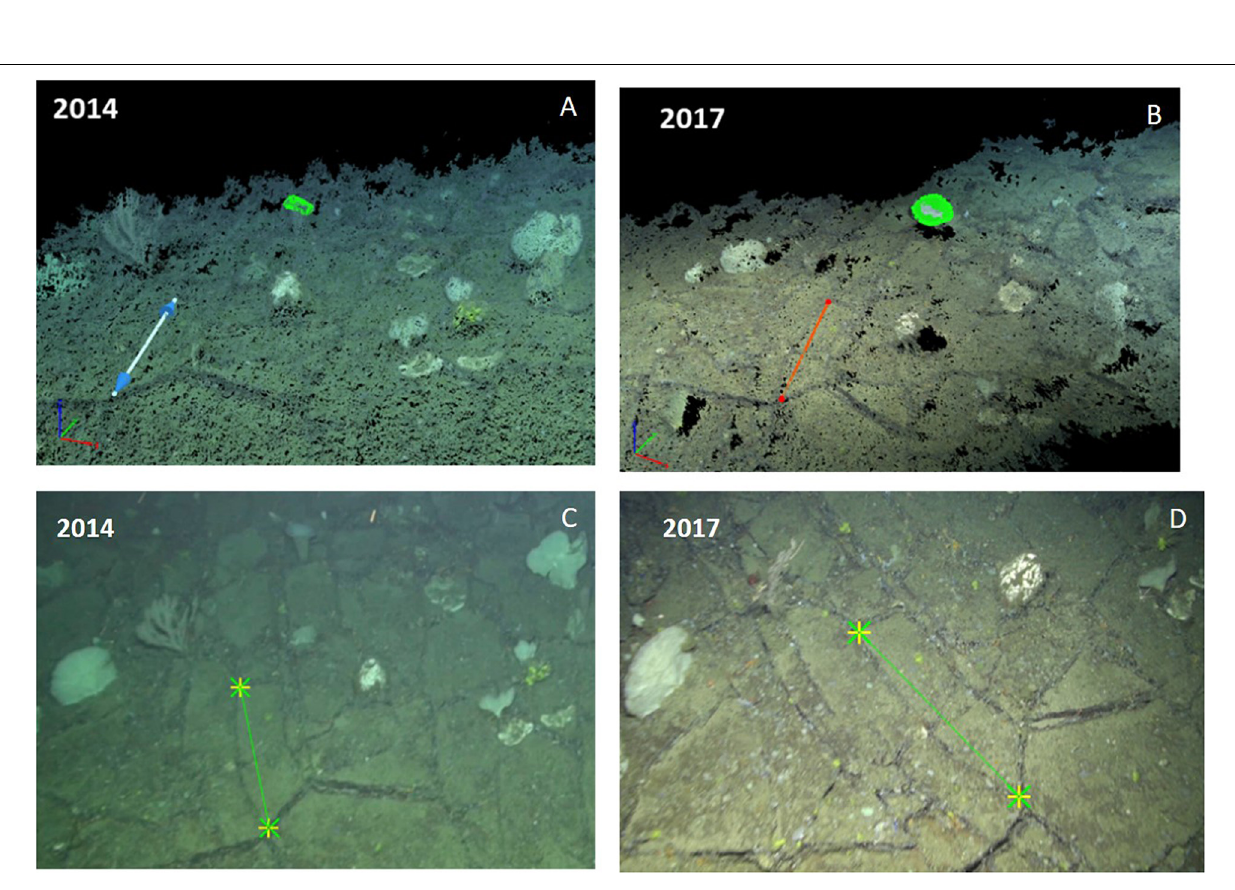
FIGURE 5 | Constant distance used for fine scaling between 3D blocks on different dates (0.88 m). (A) Distance marked in 2014 in 3D point cloud. (B) Distance marked in 2017 in 3D point cloud. (C) Distance in a 2014 video-frame where the vertices can be adjusted. (D) Distance in a 2017 video-frame where the vertices can be